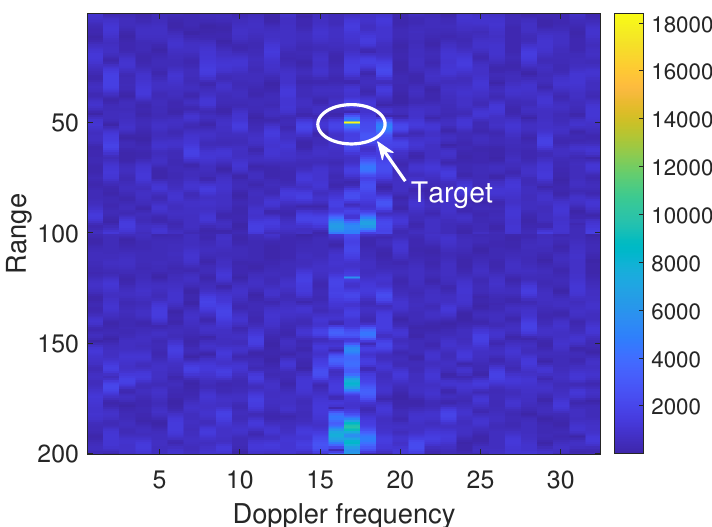
Figure 7. Range-Doppler image of the experimental data.